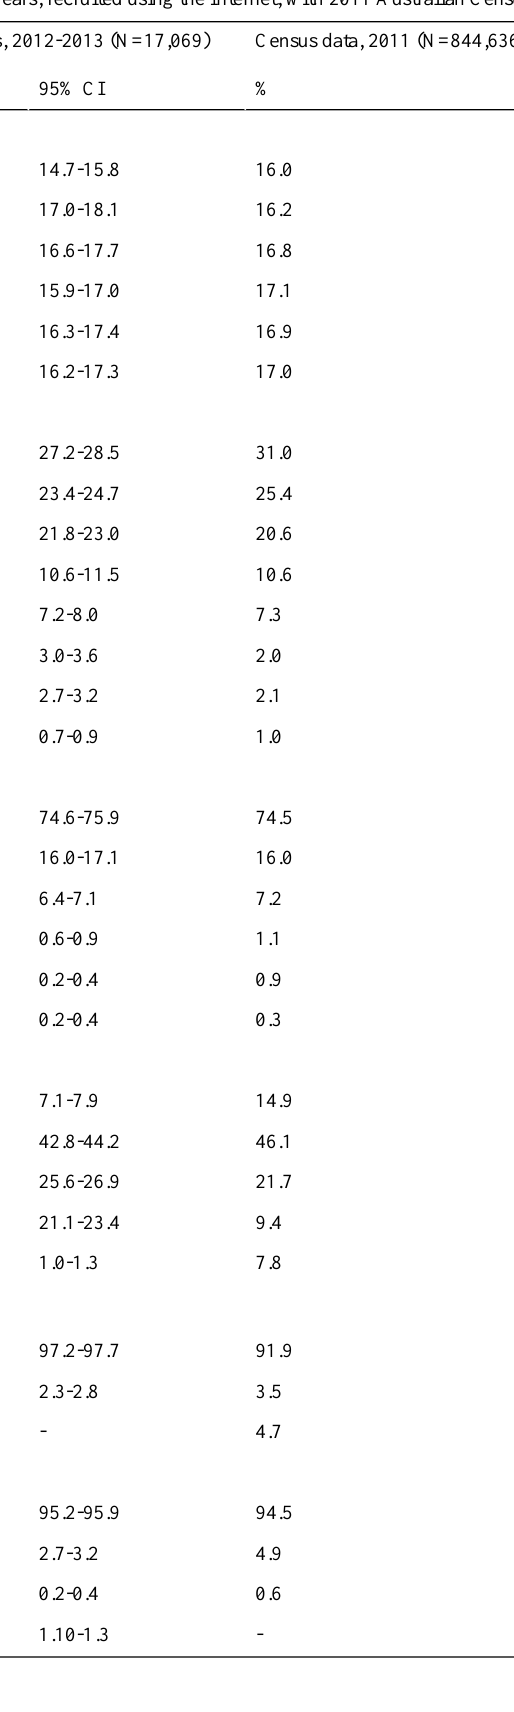
Table 1. Comparison of sociodemographic characteristics of women aged 18-23 years, recruited using the Internet, with 2011 Australian Census